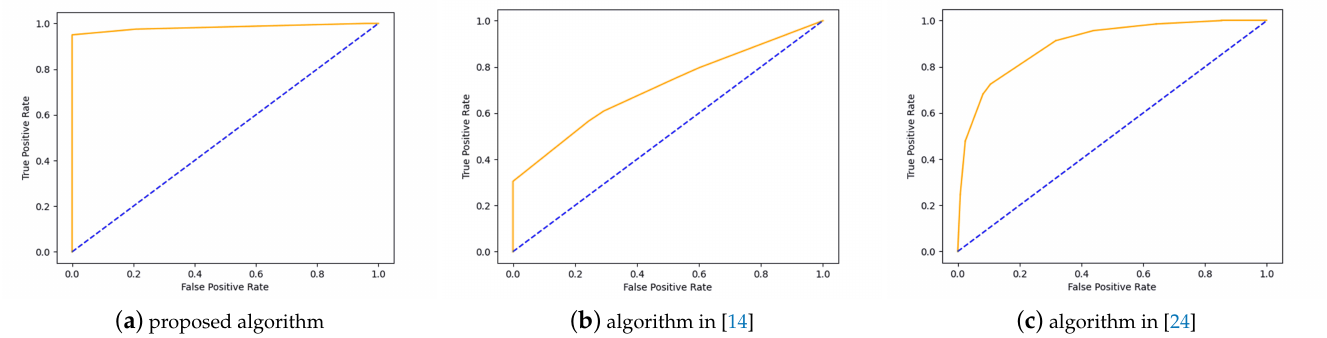
Figure 17. The ROC curve for the inspection of backplate surface for various algorithms: ( a ) ROC curve of the proposed algorithm; ( b ) ROC curve for algorithm in [14]; ( c ) ROC curve for algorithm in [24].